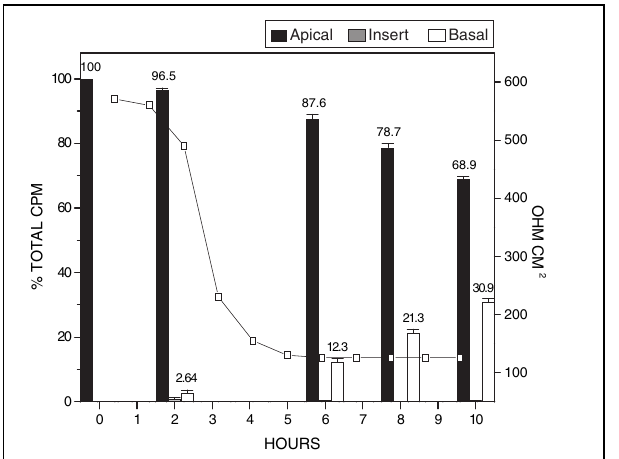
Figure 2) Translocation of 125 I-toxin A. Confluent Caco-2 monolayers on transwell inserts were inoculated with 500 µL of 125 I-toxin A (0.250 µg/mL). Samples from apical, basal, and insert were tested for per cent of the total input counts per minute (cpm). Each data point repre- sents the average of three separate experiments. The electrical resistance measurements indicate the level of tight junction integrity. The total amount of radioactivity inoculated onto the insert in the form of 125 I-toxin A was 9.2 × 10 3